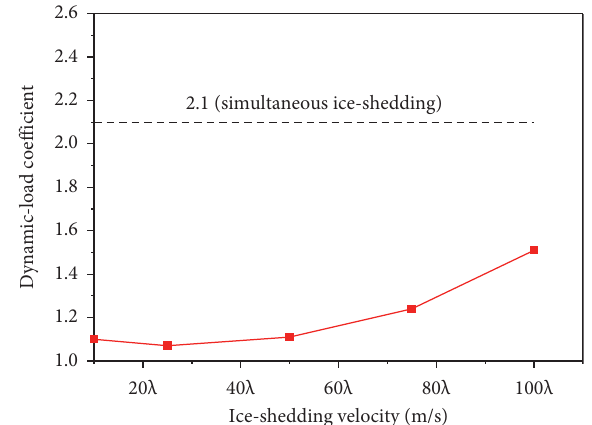
Figure 8: The variation of the dynamic-load coefficient with ice-shedding velocity.